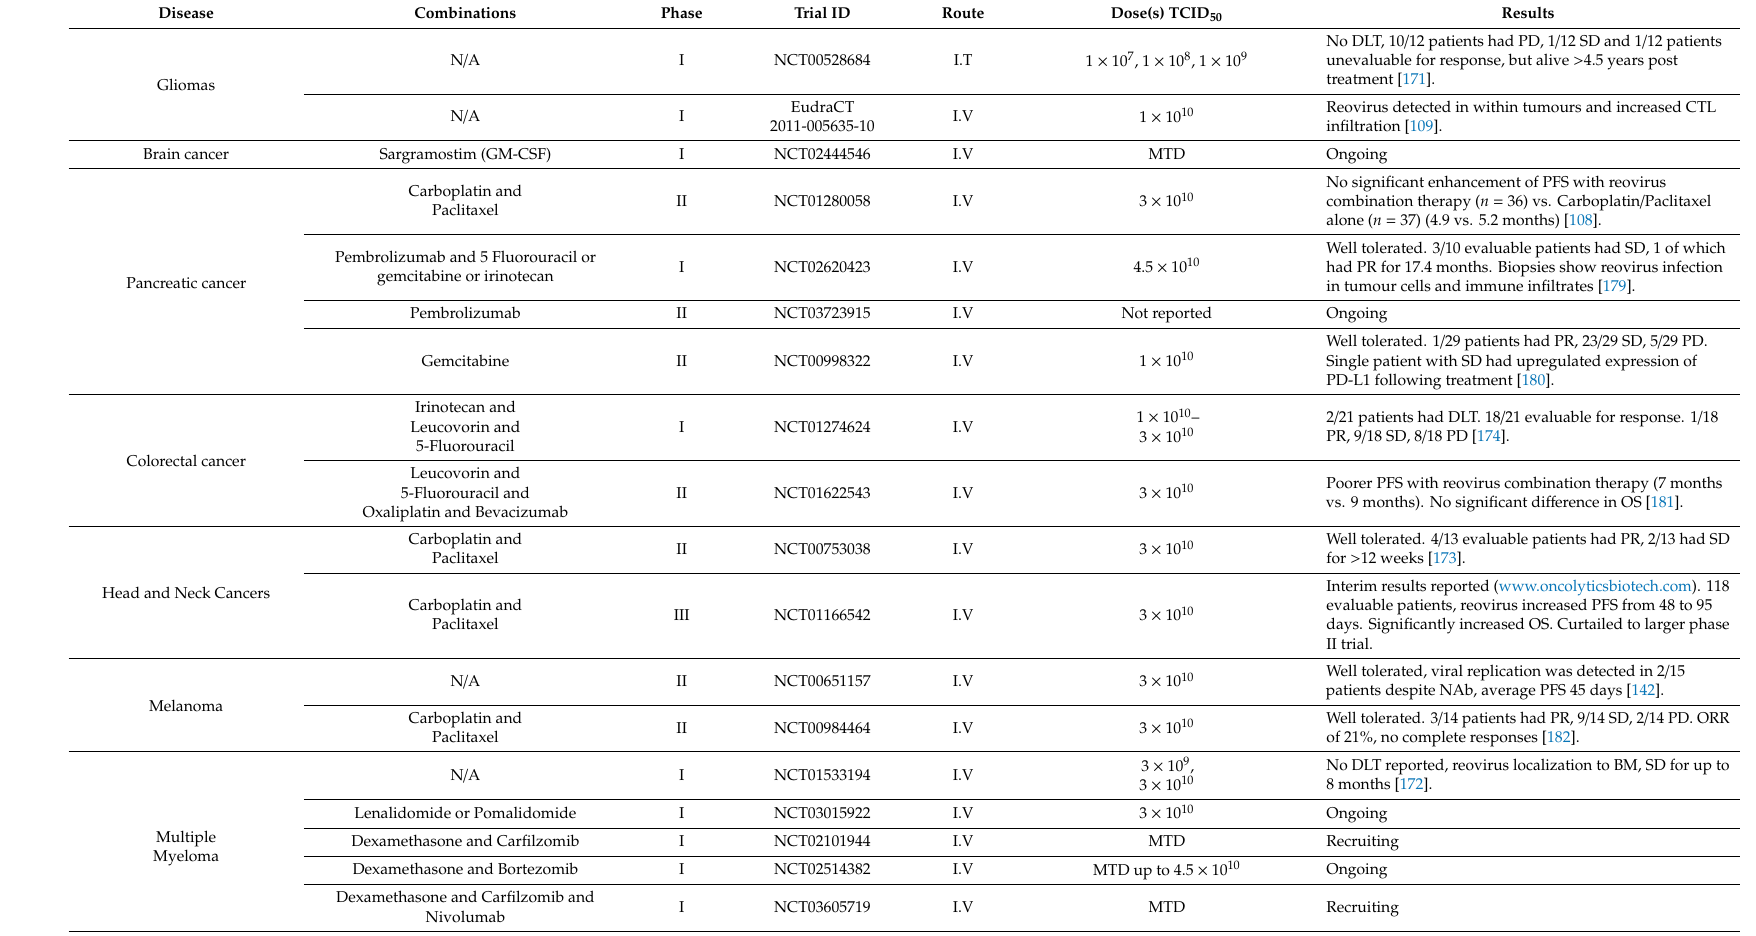
Table 1. Summary of Reovirus Clinical